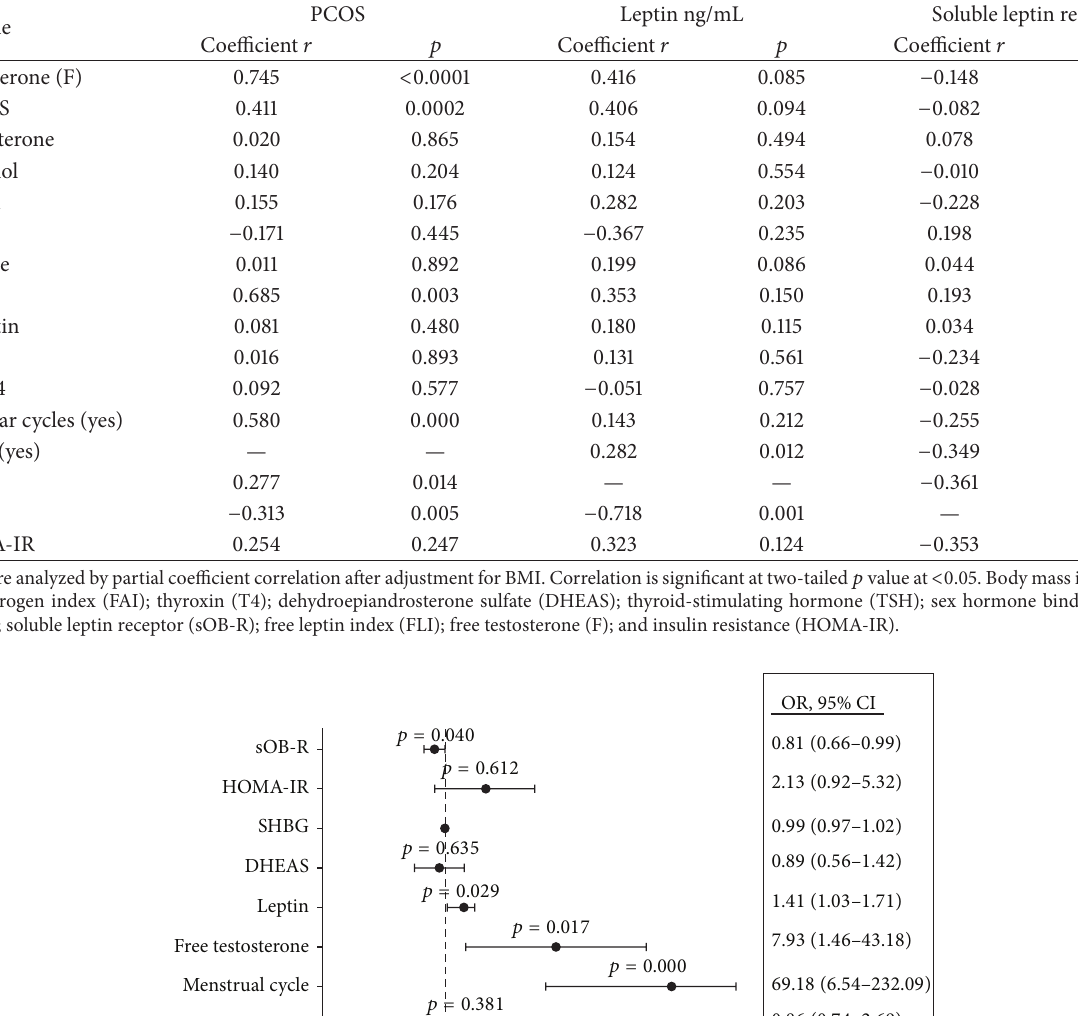
Table 4: The partial coefficient correlation of PCOS, leptin, and sOB-R in PCOS subjects.